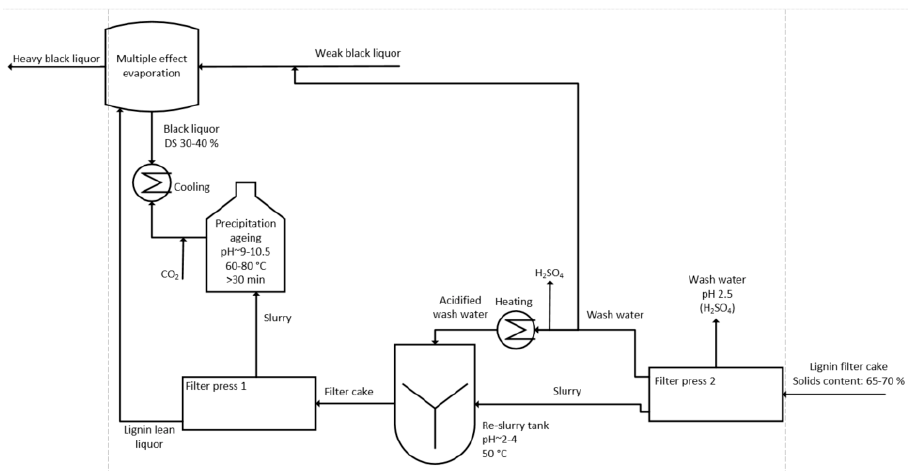
Figure 3. Schematic drawing of the LignoBoost process.